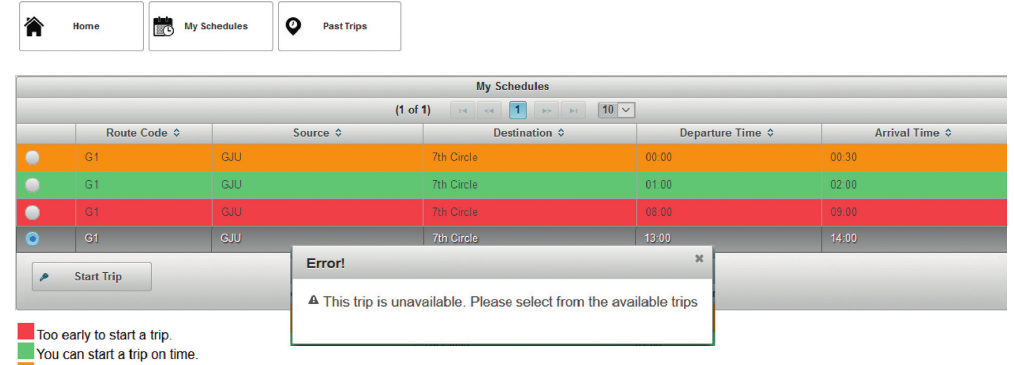
Figure 10: The schedule screen in the driver view.